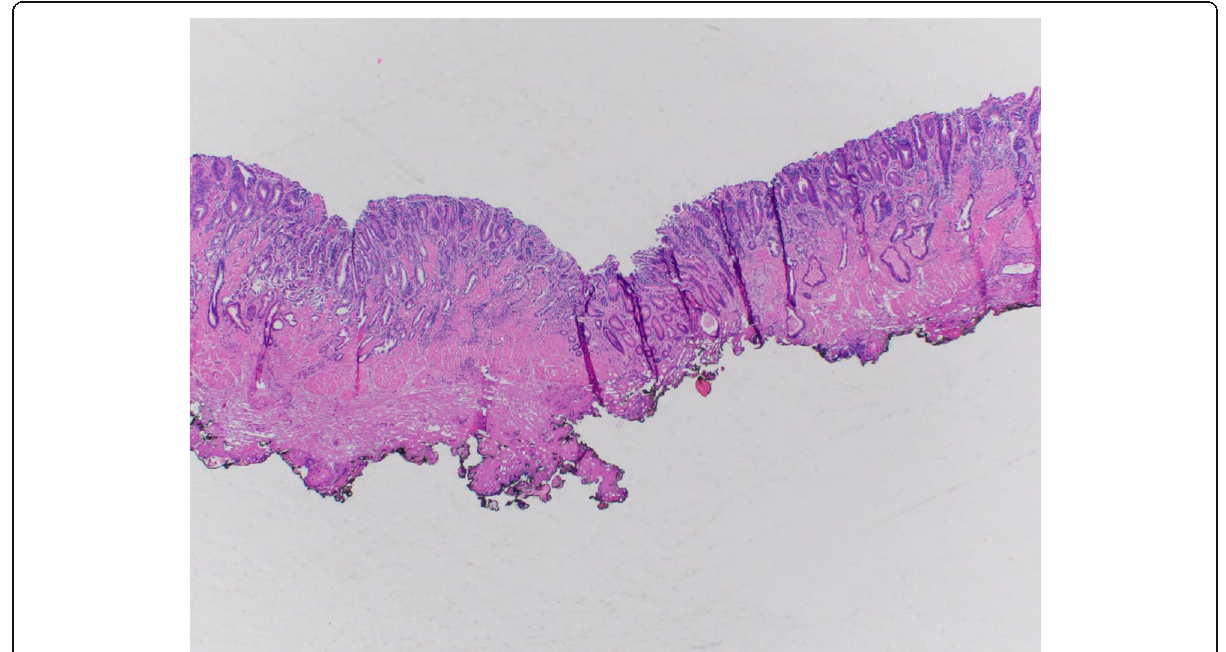
Fig. 6 Deep margin, positive for tumor due to superficial plane of resection. Hematoxylin and Eosin stain. ×